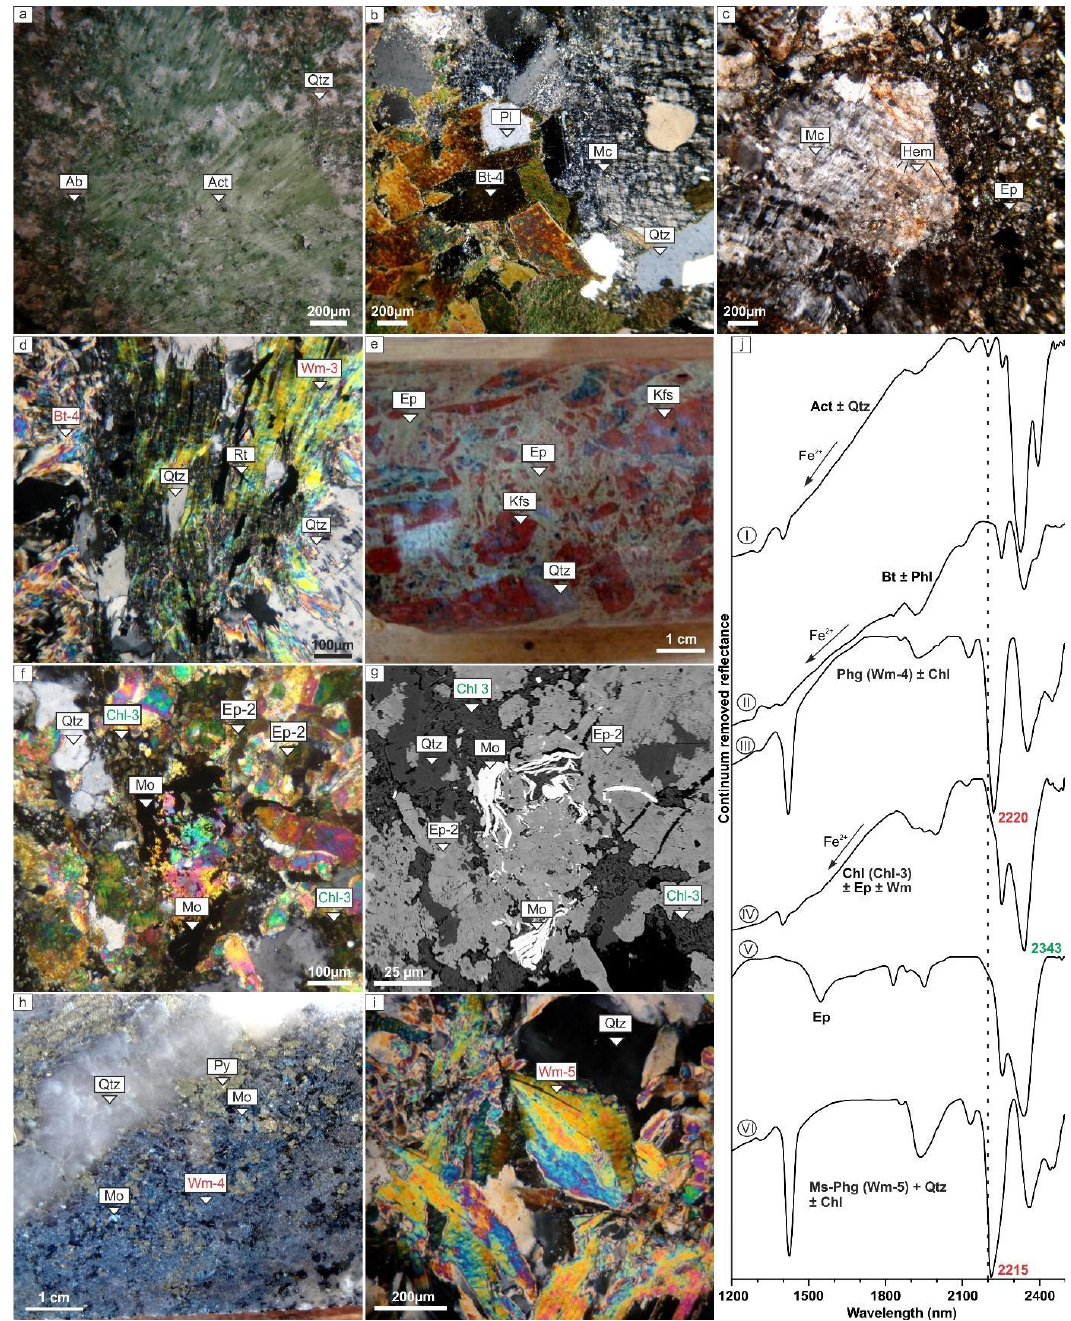
Figure 7. Group 2 hydrothermal alteration zones. ( a ) Plain-polarized and ( b – d , f , h , i ) cross-polarized thin section microphotographs; ( g ) EMP back-scattered electron image; ( h ) hand samples; and ( j ) reflectance spectra. ( a ) Fibro-radial actinolite, albite, and quartz in the calcic zone. ( b ) Large idiomorphic biotite (Bt – 4) lamellae, microcline, and quartz in the Potassic zone (sample BH041-003 in Figure 4). ( c ) Reddish microcline with abundant hematite inclusions. Biotite is partial or totally substituted for epidote and titanite from the propylitic zone (sample BH041-003). ( d ) Biotite (Bt – 4) from the potassic zone is transformed into Wm – 3, quartz, ilmenite, rutile, and titanite from the phyllic zone (sample BH059-009). ( e ) Epidote breccia containing subangular k-feldspar-hematite altered clasts with abundant epidote cement (Ep – 2) (sample BH041-012). ( f , g ) Chl – 3, epidote (Ep – 2), and molybdenite in the epidote breccia zone (sample BH041-012). ( h ) Halos of Wm – 4, chlorite, pyrite, and molybdenite in a quartz–pyrite veinlet from the breccia zone (sample BH041-012). ( i ) Details